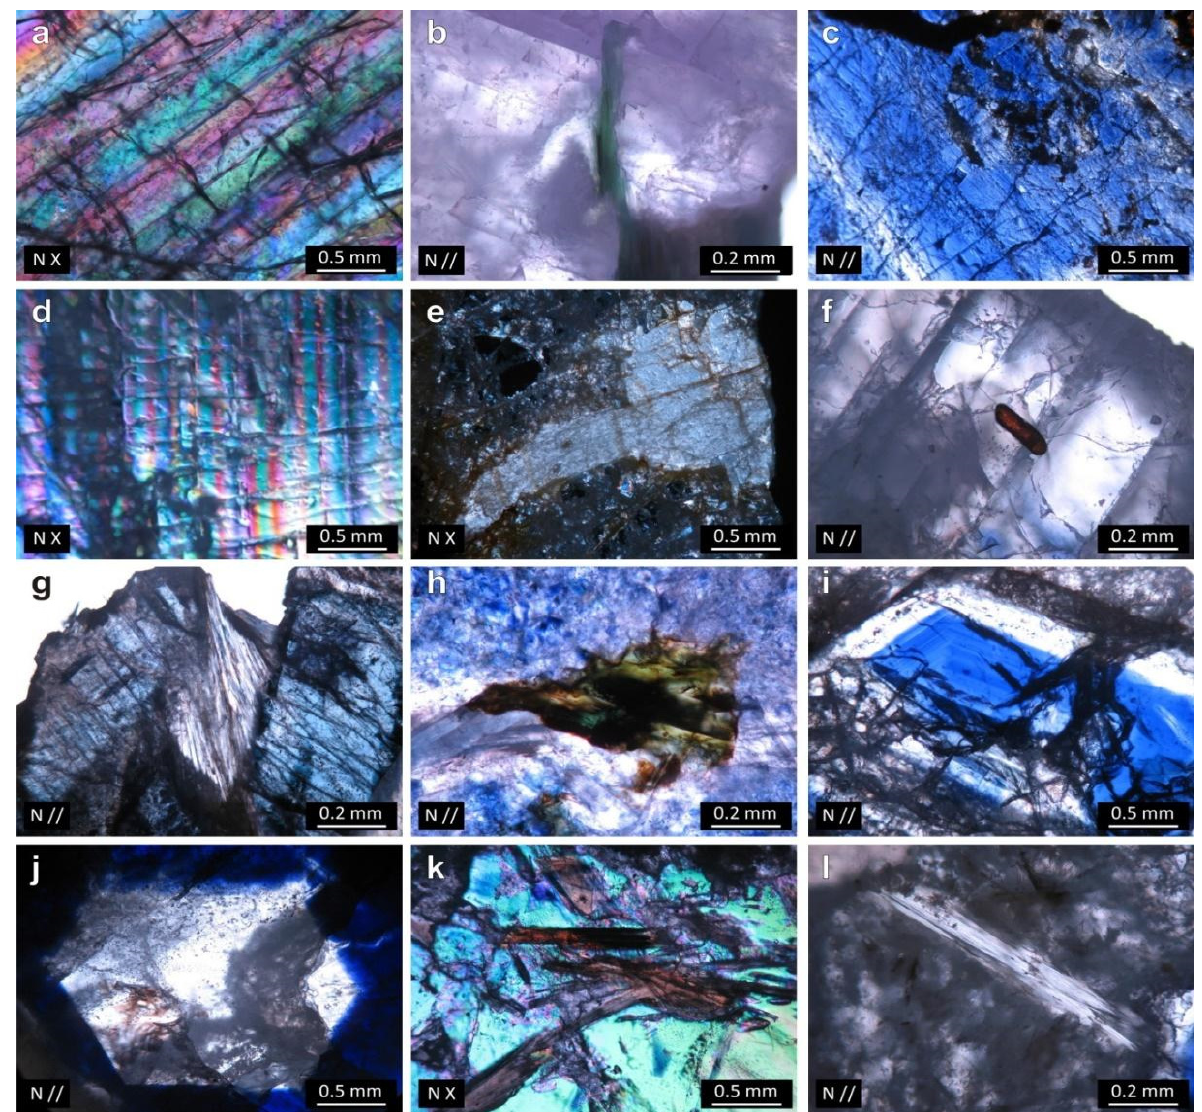
Figure 3. Microphotographs of thin sections of the studied corundum from Greece under transmitted polarized light microscope. N//=parallel nicols; NX=crossed nicols. ( a ) Parting and polysynthetic twinning in sample DR1a from Paranesti; ( b ) chlorites filling a crack in sample DR1a from Paranesti; ( c ) heavily fractured blue color corundum crystal, exhibiting strong pleochroism (sample GORa); ( d ) partings and polysynthetic twinning in pink sapphire from Gorgona (sample GO5a); ( e ) kyanite crystal in sapphire from Gorgona (sample GORa); ( f ) allanite inclusion in corundum from Gorgona (sample GO5a); ( g ) two euhedral blue corundum crystals with a margarite inclusion in between (sample IK1b); ( h ) biotite inclusion replaced by chlorite in sapphire from Ikaria (sample IK1b); ( i ) hexagonal euhedral corundum crystal with a blue core surrounded by a colorless rim (sample NX2a) from Naxos (Kinidaros); ( j ) sapphire from Naxos (Kinidaros) exhibiting a colorless core surrounded by a blue rim (sample NX2a); ( k ) biotite inclusions in a corundum crystal from Naxos (Kinidaros, sample NX1a); ( l ) chlorite with anomalous interference colors included in a sapphire crystal from Naxos (Kinidaros, sample